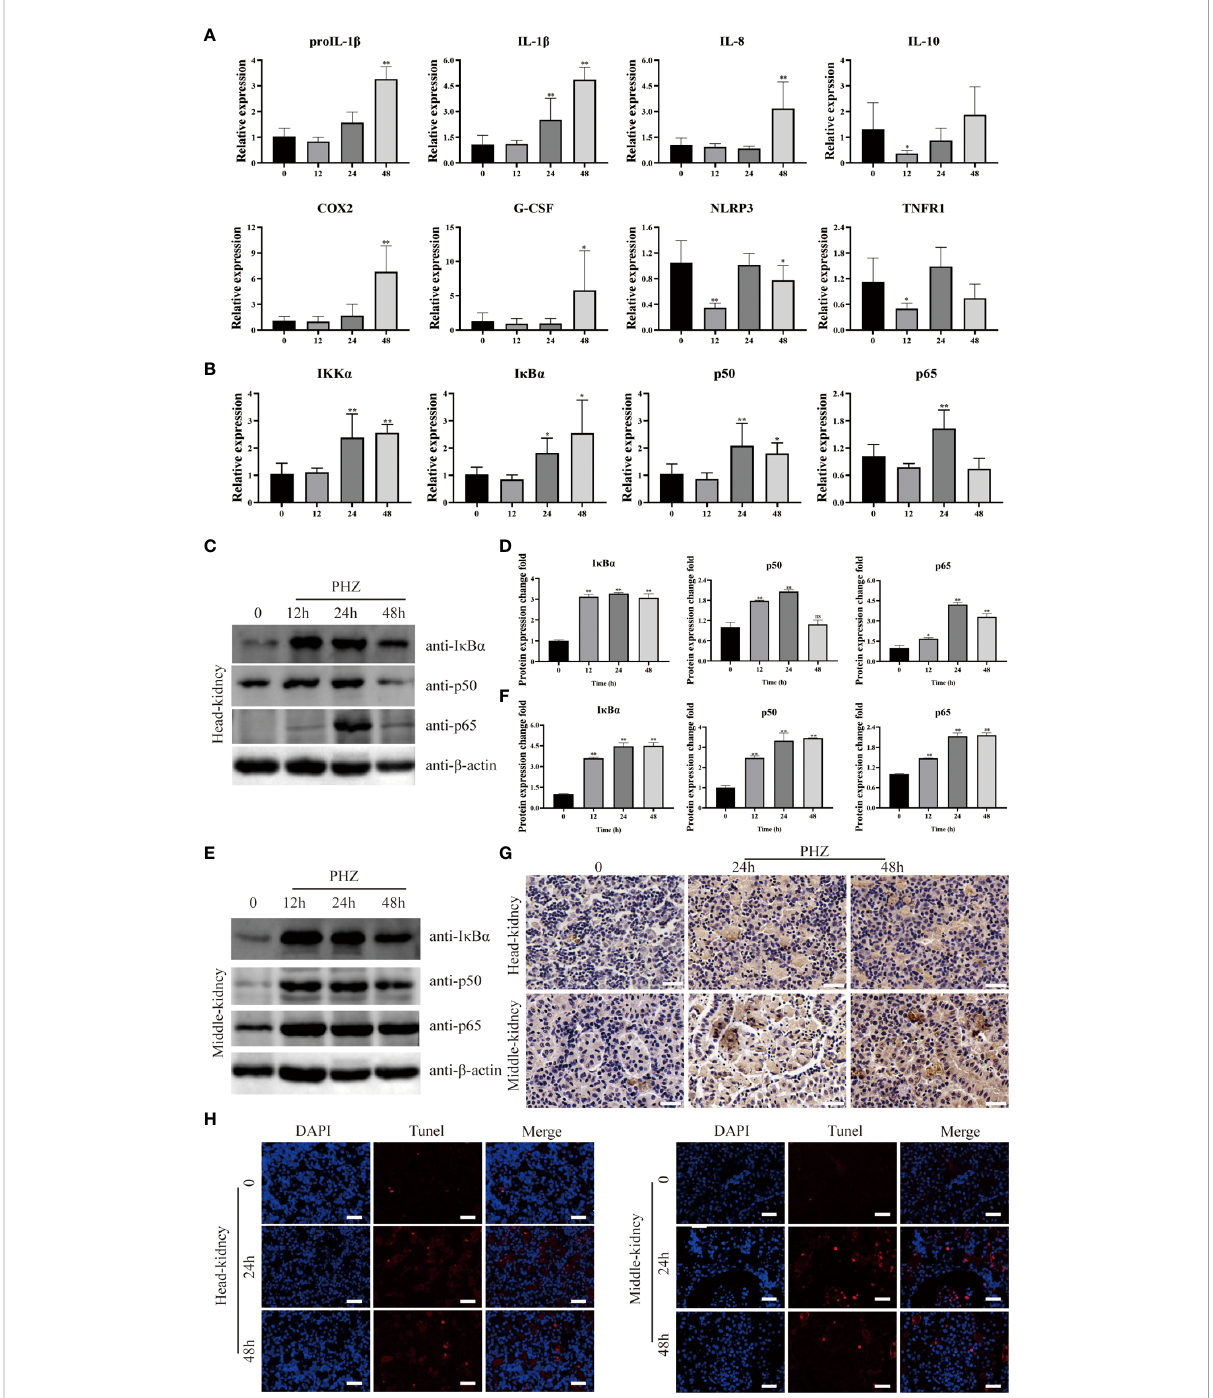
FIGURE 3 Hemolysis can regulate in fl ammation through NF- k B signaling pathway. (A, B) The qRT-PCR was used to detect the mRNA expression levels at 12 h, 24 h and 48 h after PHZ injection in head kidney, including ProIL-1 b , IL-1 b , IL-8, IL-10, COX2, G-CSF, NLRP3, TNFR1 (A) and IKK a , I k B a , P50, P65 (B) . (C – F) The protein expression levels of I k B a , P50 and P65 in the head kidney (C, D) and middle kidney (E, F) after PHZ injection 12 h, 24 h, and 48 h were detected by WB, and the gray scale analysis was performed by image J (G) The IHC was used to analysis the expression of I k B a in head and middle kidneys after injection of PHZ 24 and 48 h. Scale means 20 m m. (H) TUNEL staining was used to detect the apoptosis of head and middle kidney (red) after injection of PHZ 48 h. The scale bar was 20 m m. The data were the mean values of three independent experiments, expressed as mean ± SEM ( *P < 0.05, **P <